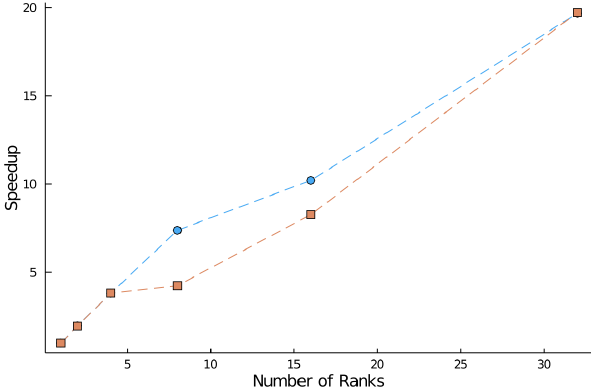
Figure 15. Speed-up of the time integration (solver) step relative to the time to solution for a single-rank simulation of the rising thermal bubble problem in an 8 . 192km 3 domain with a uniform effective resolution of 32m (with fourth-order polynomials). Blue circles: dry simulation; orange squares: moist simulation.